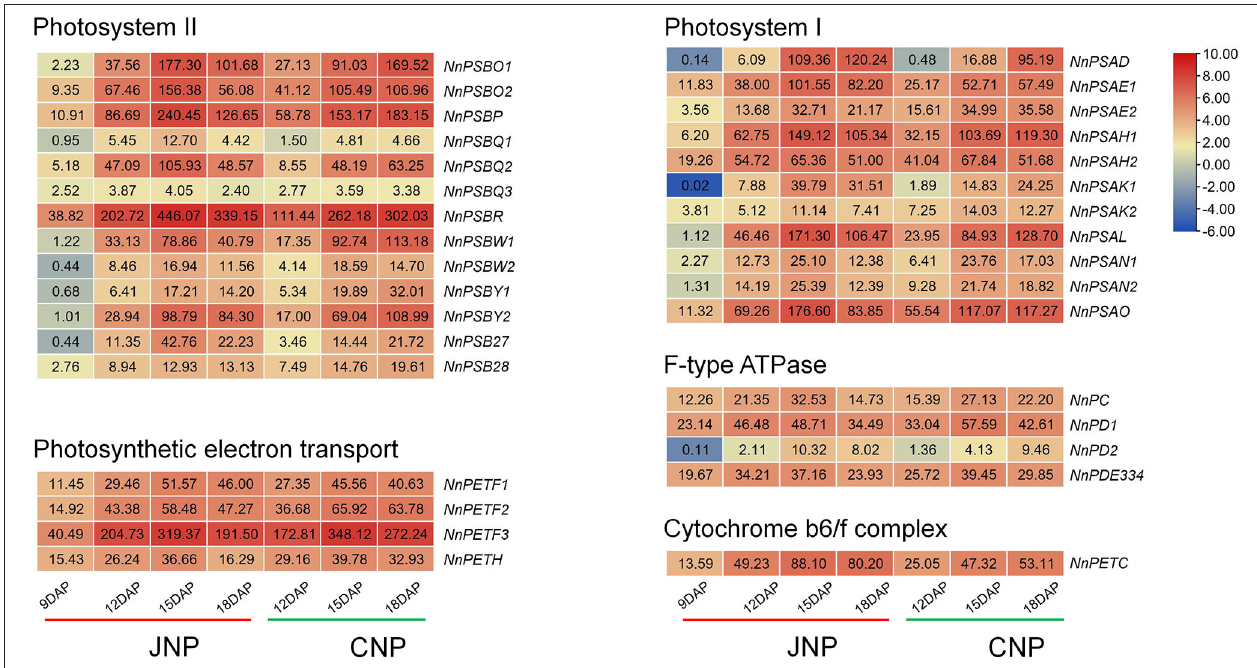
FIGURE 5 | Expression analysis of photosynthesis-related genes during lotus plumule